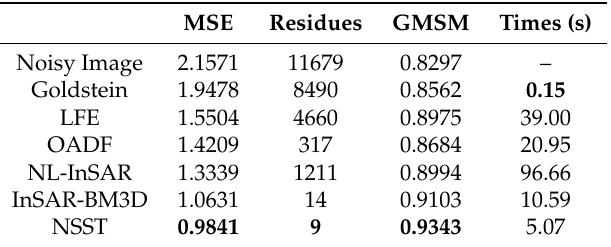
Figure 10. The filter results of the interferogram generated by a cone with variable coherence ( top ), the residuals graph ( middle ) and the Gradient Magnitude Similarity (GMS) map ( bottom ). Table 5. Performance of various